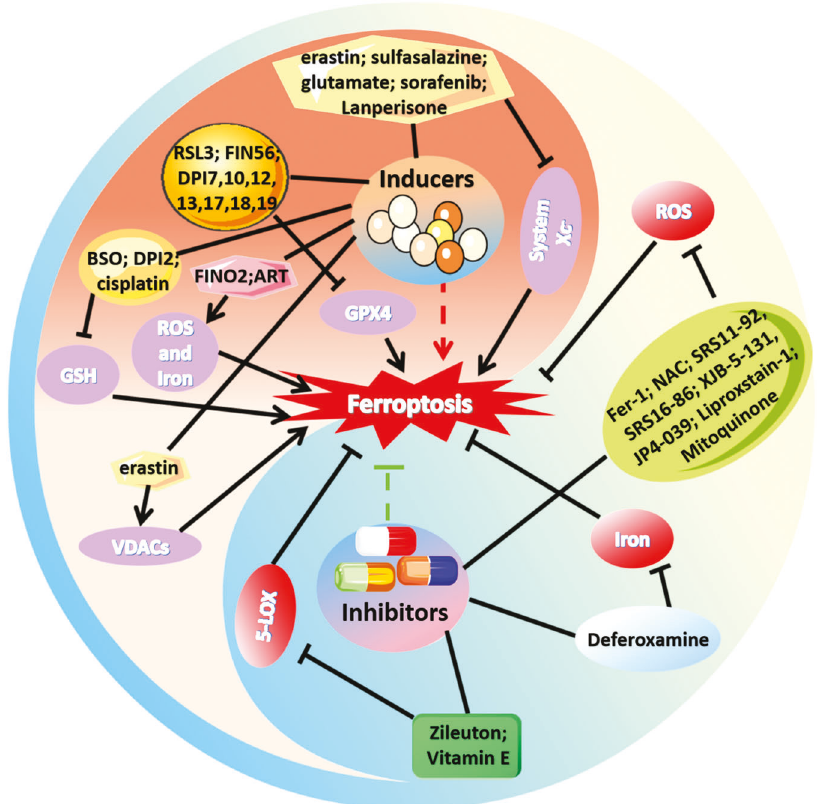
ferroptosis. The arrows indicate promotion, and the blunted lines indicate